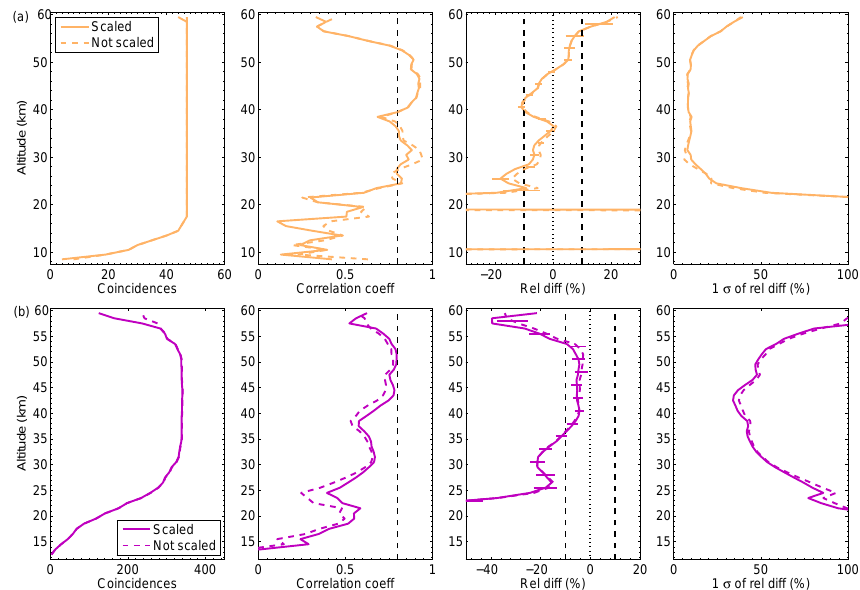
Figure 4. Comparisons of diurnally scaled (solid lines) and non-scaled (dashed lines) ACE-FTS NO profiles with (a) HALOE data within 3h and 500km, and (b) MIPAS IMK-IAA data within 3h and 100km. From left to right, the plots show number of coincident profiles, correlation coefficient profiles, mean relative difference profiles (ACE-FTS − INST) in percent, and standard deviation of relative difference profiles in percent. Error bars in the relative difference profiles represent the standard error of the mean.